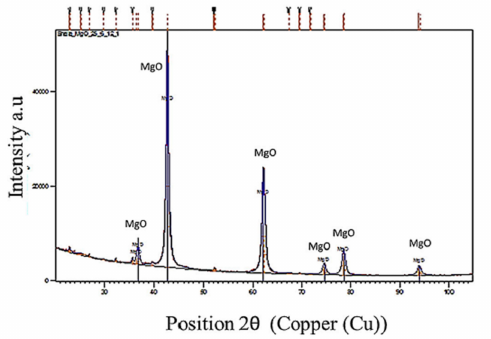
Figure 8. XRD of the calcined MgCO 3 · xH 2 O and the plastic blend at 1250 ◦ C–Non-Soot